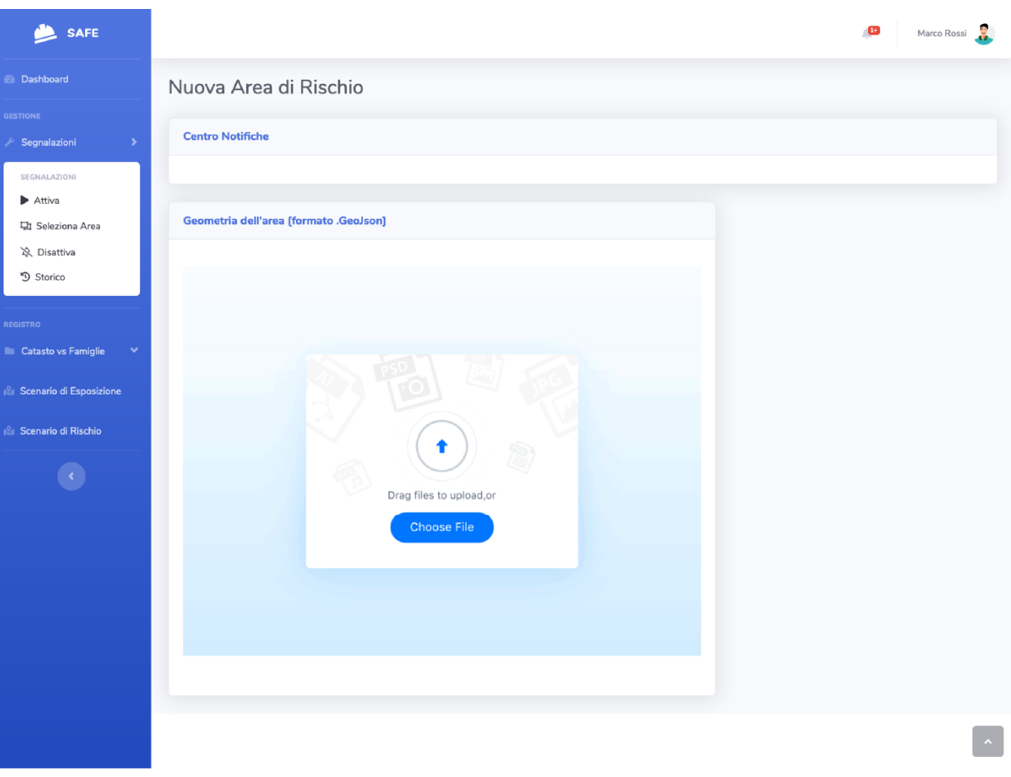
Figure 17. Updating the set of pre-defined risk areas.